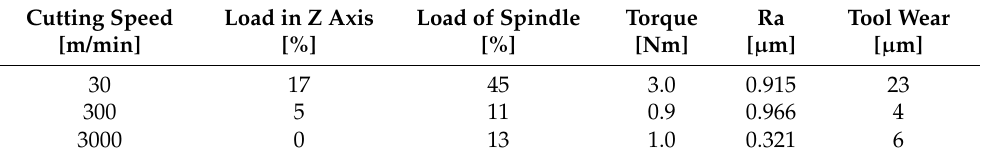
Table 9. Influence of cutting speed on significant observed parameters during machining of zirconia.